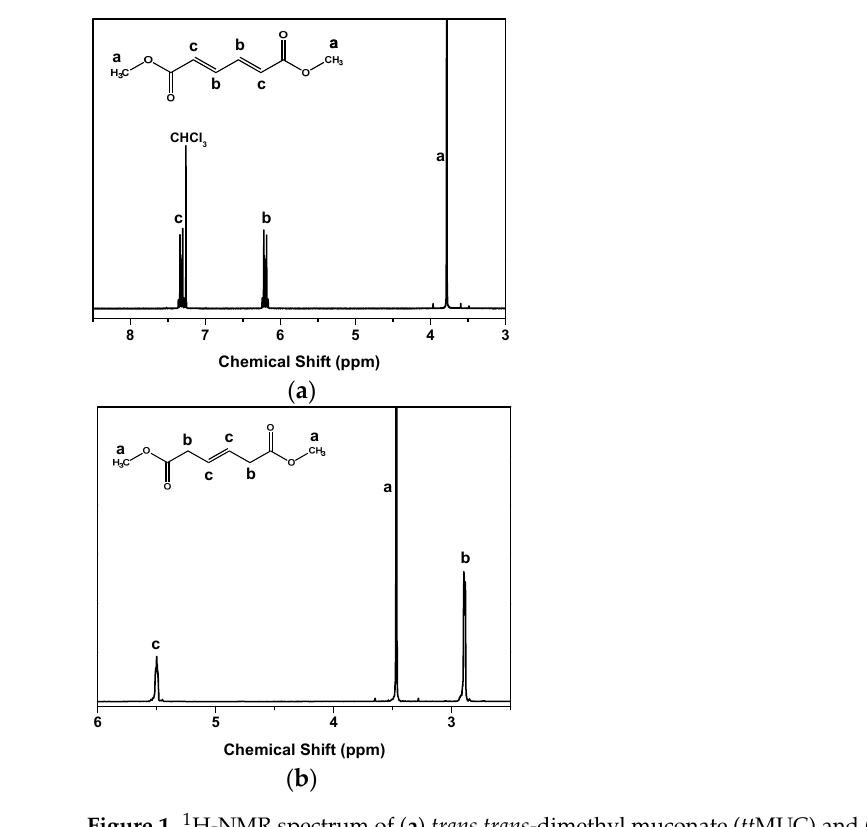
Scheme 1. Synthesis route for the production of ( a ) trans,trans -dimethyl muconate ( tt MUC) and ( b ) trans, β -dimethyl hydromuconate (TBHM) via esterification and isomerization.